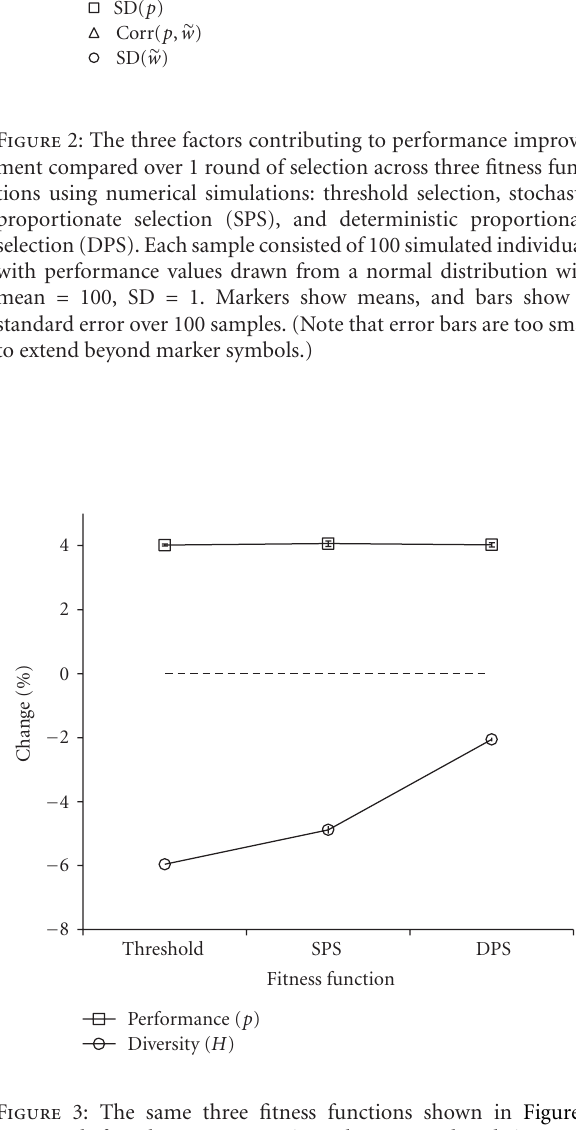
Figure 3: The same three fitness functions shown in Figure 2 compared for the one-generation change produced in mean performance, and in population diversity. Bars show standard errors. (Note that error bars are too small to extend beyond marker